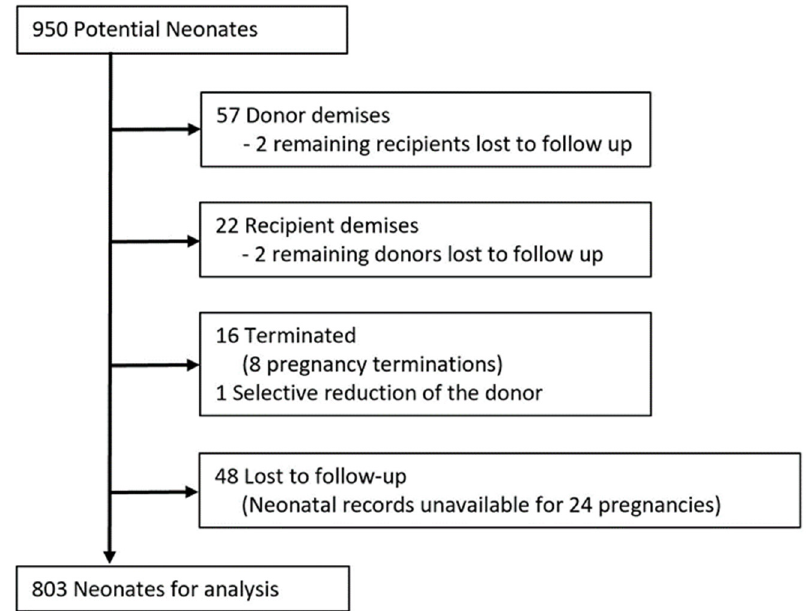
Figure 2. Kaplan–Meier curves comparing ( A ) gestational age of delivery, ( B ) the interval between FLP and delivery, ( C ) the interval from FLP to PPROM, and ( D ) the interval from PPROM to deliv- ery in patients who had vs. did not have IOS. p -values are for log-rank tests comparing survival distributions.